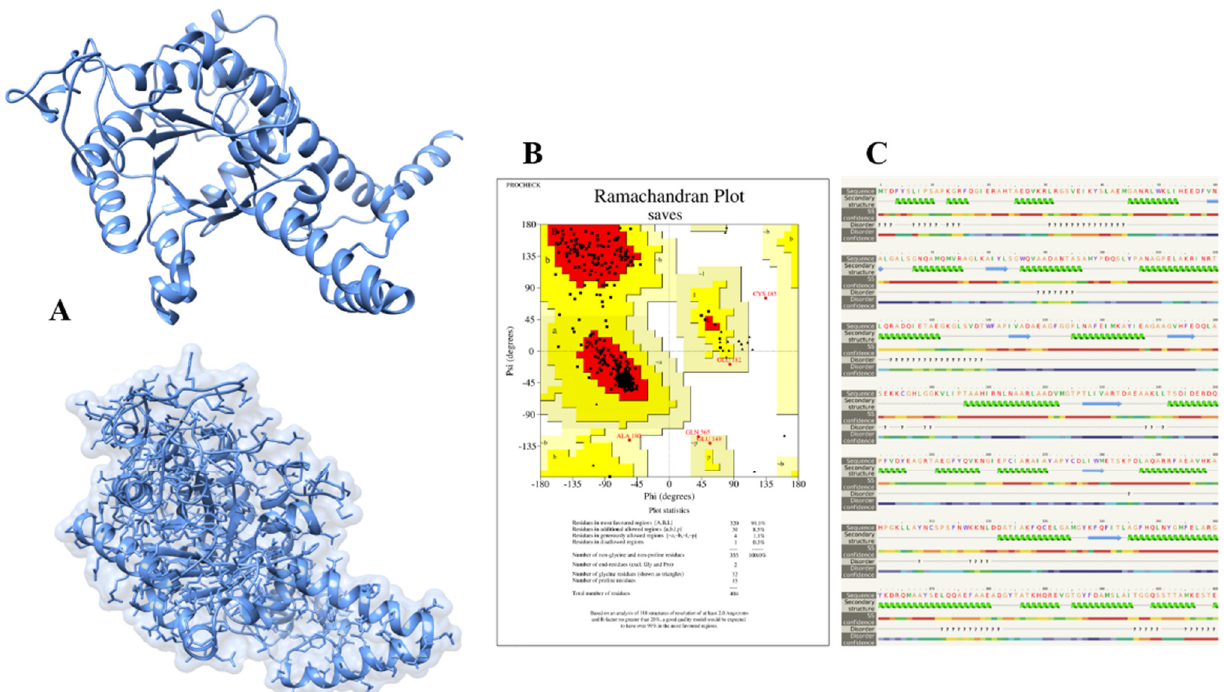
Figure 3. Modeled structure of isocitrate lyase. ICL modeled protein structure using a template- based approach. The predicted secondary structure of isocitrate lyase is exhibited by different signs and colors, such as: green helices represent alpha-helices, blue arrows indicate β -strands, a sign of interrogation (?) assigns a disordered region, and the paint line indicated the coil. The confidence of the predicted secondary structure is indicated by colors, red means high confidence, and blue color shows low confidence of secondary structure prediction ( A ) its validation via Ramachandran plot resulting in the structure validity for 90% and ( B ) secondary stricture prediction via Pyre2 tool ( C ).